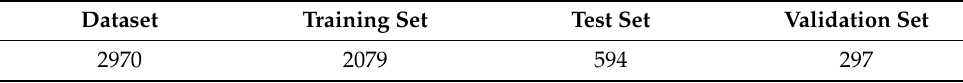
Table 1. Partitioning of the data set in the